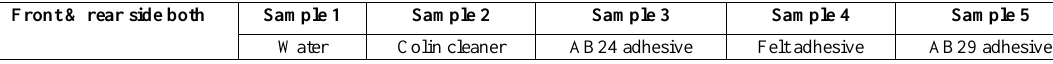
Table1. Five test samples to check